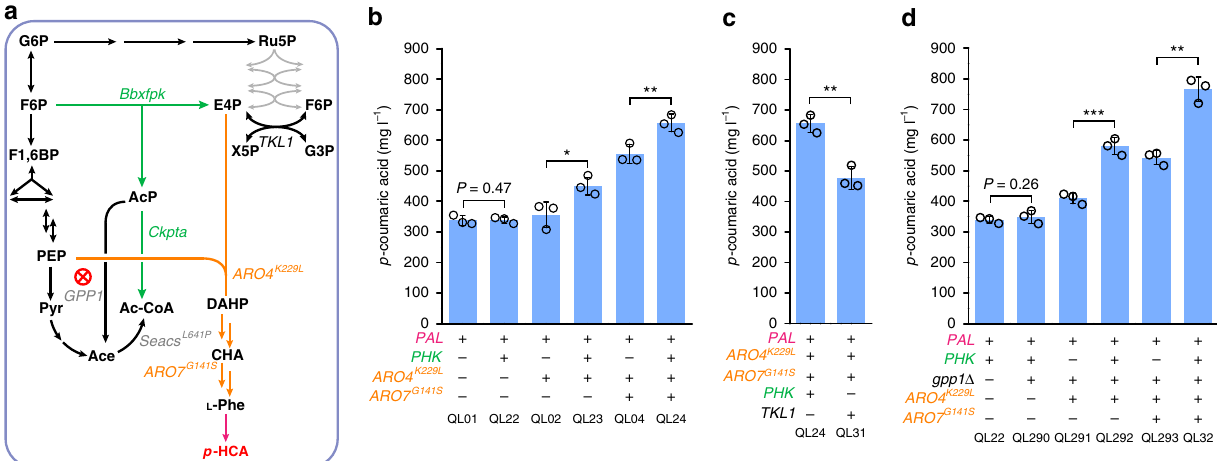
Fig. 3 Validation of a phosphoketolase-mediated E4P generation route in the basic PAL branch strains. a Schematic overview of phosphoketolase (PHK)- based pathway for the generation of E4P for p -HCA production. The heterologous PHK pathway, consisting of a phosphoketolase from Bi fi dobacterium breve (BbXfpk) and a phosphotransacetylase from Clostridium kluyveri (CkPta), was introduced into the PAL branch-based (including a phenylalanine ammonia lyase and a cinnamic acid hydroxylase) strain. Ace acetate; see Fig. 1 legend regarding abbreviations of other metabolites. b Introduction of the PHK pathway in combination with feedback-insensitive DAHP synthase ( ARO4 K229L ), and chorismate mutase ( ARO7 G141S ) increases p -HCA titers via the